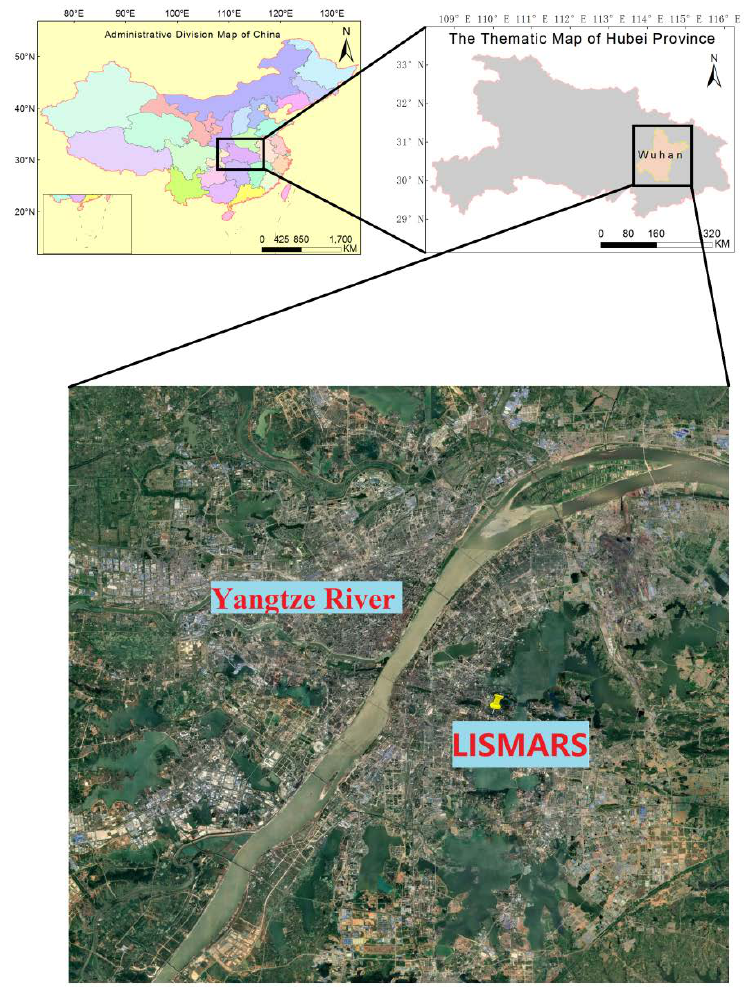
Figure 1. The experiment location of the observation site.